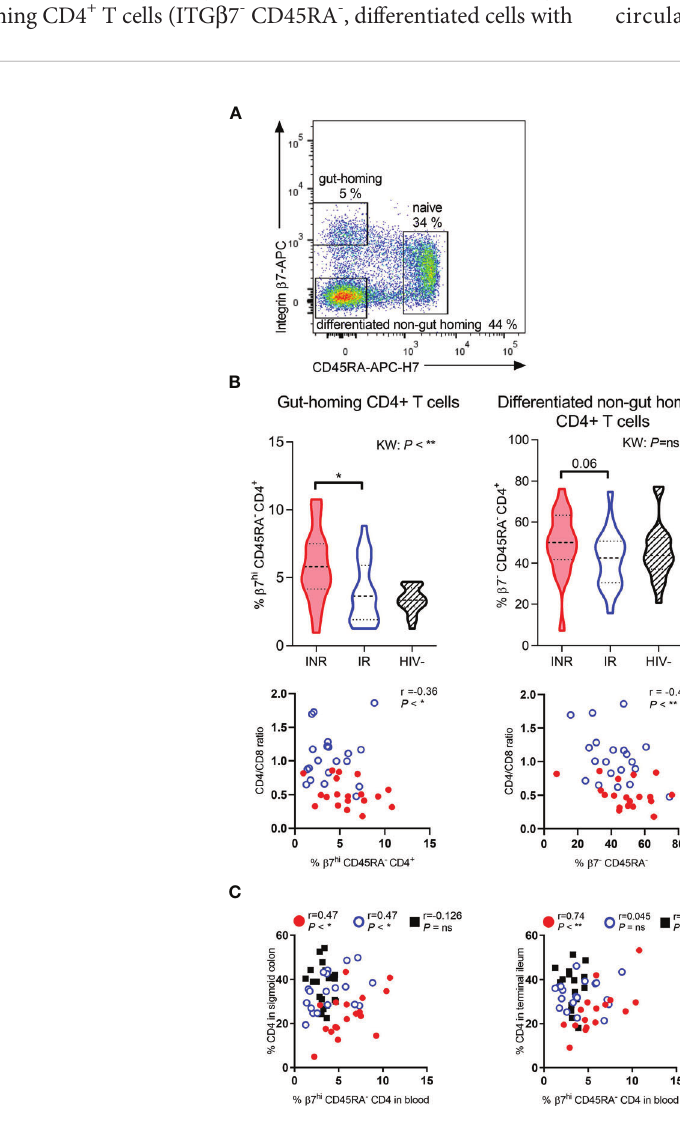
FIGURE 1 | INR have higher fractions of gut-homing CD4 + T cells in blood correlating with mucosal CD4 + T cell fractions. (A) Representative fl ow cytometry plot of gut-homing (integrin b 7 high CD45RA neg ), differentiated non-gut homing (integrin b 7 neg CD45RA neg ), and naive (integrin b 7 neg/int CD45RA pos ) CD4 + T cells in blood. (B) Upper part: Comparison of the percentages of gut-homing (left panel), differentiated non-gut homing (middle panel), and naive (right panel) CD4 + T cells in immunological non-responders (INR), immunological responders (IR) and HIV negative donors. Lower part: Correlation between CD4:CD8 ratio and gut-homing (left), differentiated non-gut homing (middle), and naive (right) CD4 + T cells. (C) Correlation between the percentage of CD4 + T cells in sigmoid colon (left) and terminal ileum (right) and gut-homing CD4 + T cells in blood. INR indicated as red violin plots/dots, IR as open blue violin plots/circles, HIV negatives as lined black violin plots/ black squares (dashed lines: median, dotted lines: quartiles). Statistical analyses were performed by Kruskal Wallis (KW) test with Dunn ’ s post-test between INR and IR and Spearman correlation. Spearman computed on all data combined or on each distinct study group. * P < 0.05, ** P < 0.01, ns, not signi fi